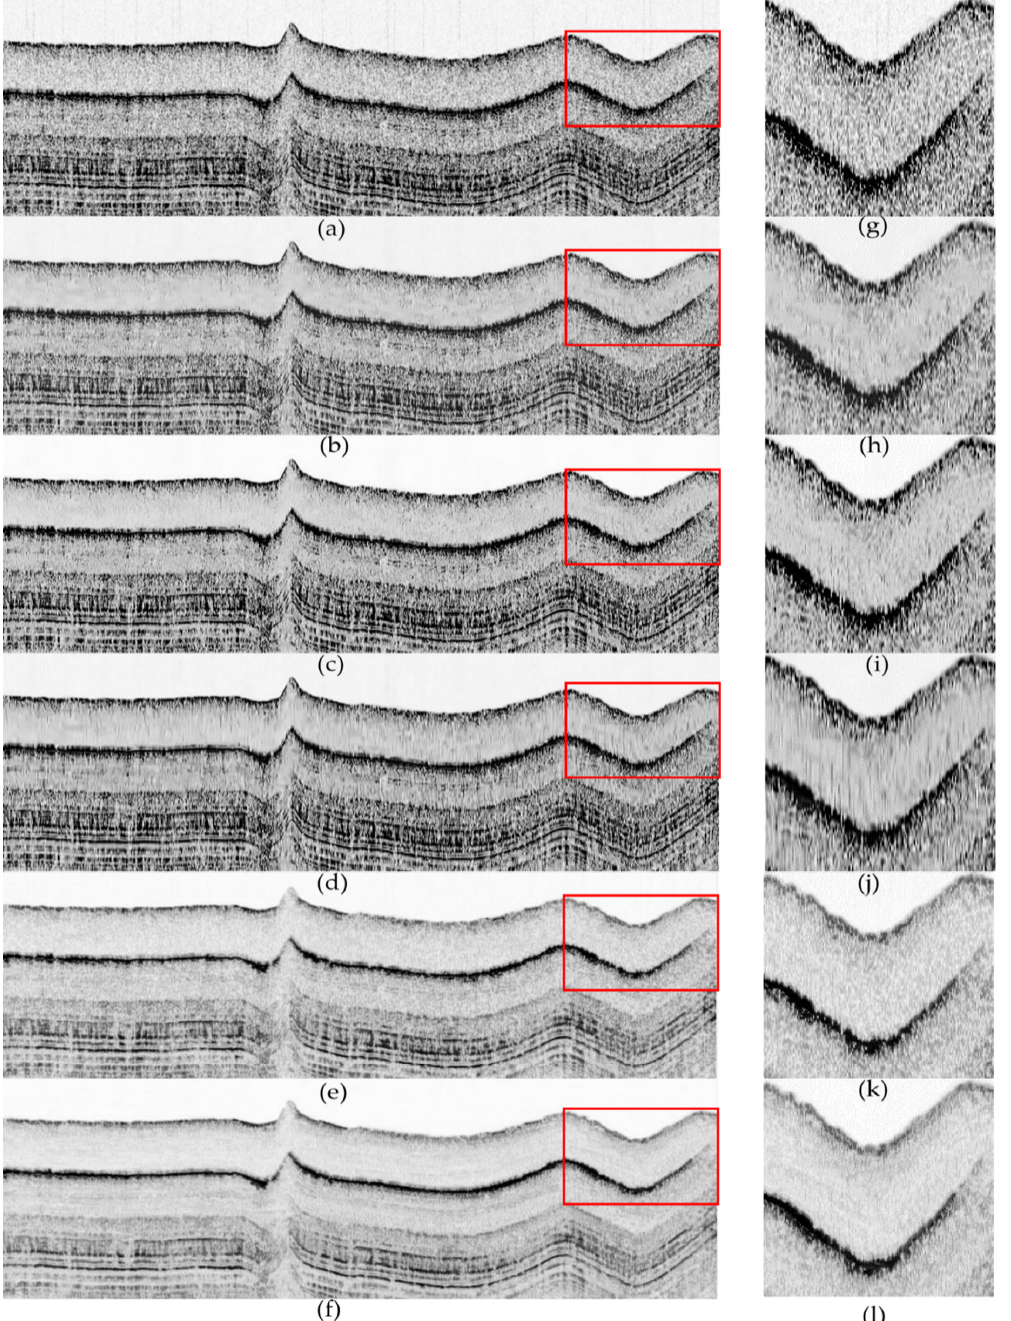
Figure 11. Filtering results: ( a ) is the SBP image, ( b – f ) are the filtered results using KSVD, NLM, BM3D, NLLR, and the proposed method, ( g ) shows the details of the SBP image in the rectangle area in Figure 11a, ( h – l ) are filtered results in the rectangle area in Figure 11a using KSVD, NLM, BM3D, NLLR, and the proposed method.